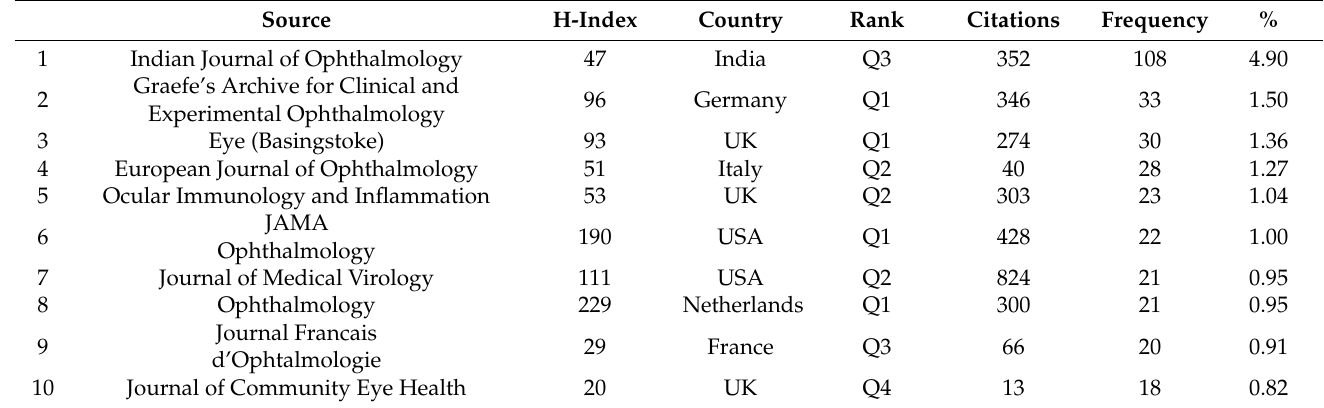
Eye (Basingstoke) Table 3. Top 10 active journals in publishing in eye-related COVID-19 literature (2019–2021) N = 2206. Source